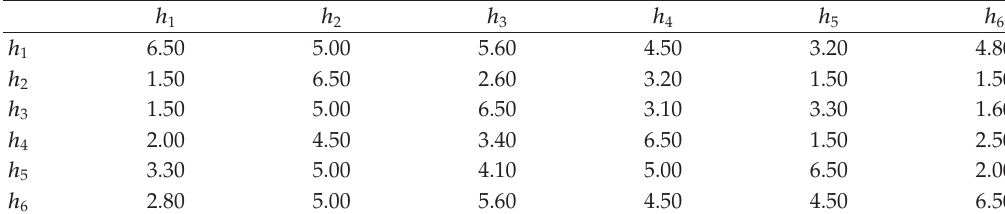
Table 2: The generalised comparison table about (cid:2) F α .